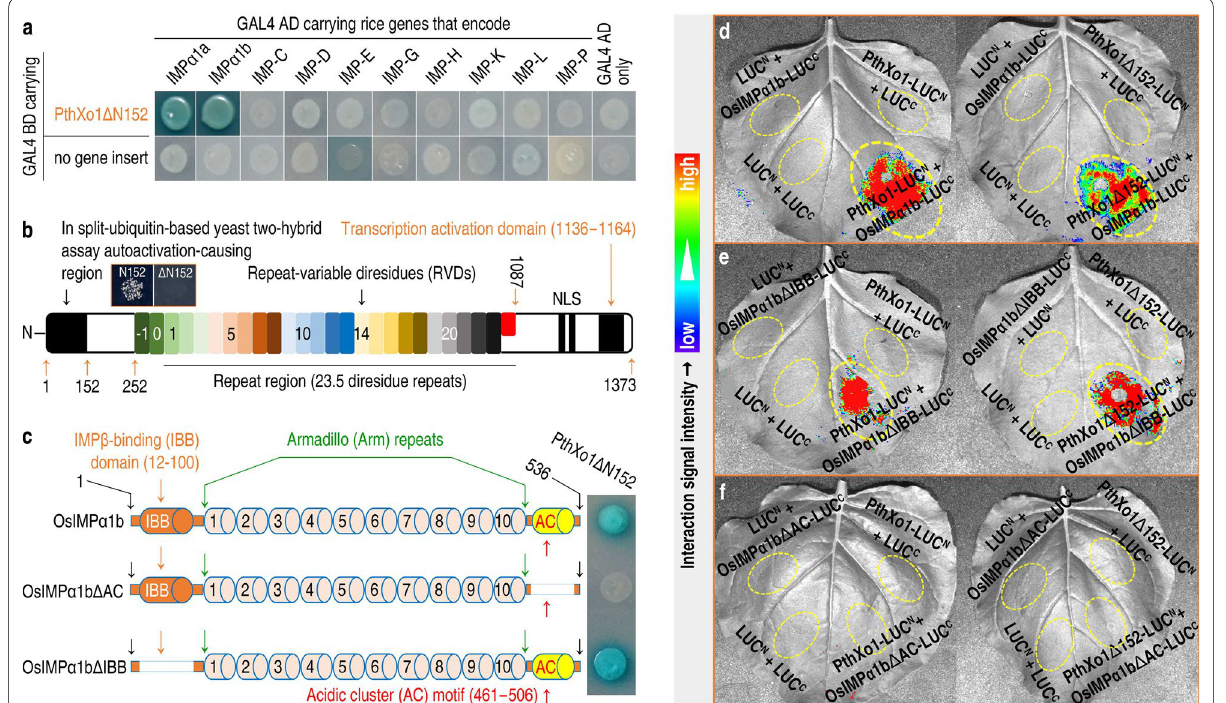
Fig. 1 OsIMPα1a and OsIMPα1b interact with PthXo1. a OsIMPα1a and OsIMPα1b were identified as interactors of PthXo1 in split-ubiquitin-based yeast two-hybrid (SUB-Y2H) assays of PthXo1 in combination with each of the indicated IMPs from rice. The protein ‒ protein interactions were detected by an X-Gal assay of colonies grown on synthetic dropout (SD)-amino acid tryptophan-leucine nutrient (SD-WL) media. b Diagram of PthXo1 structural components, including the 152-amino acid-long N-terminal sequence, which is responsible for autoactivation of the protein. The inset shows the presence and absence of colonies growing on SD-tryptophan-leucine-alanine-histidine (SD-WLAH) medium from yeast cultures that produce full-length PthXo1 protein or the PthXo1Δ152 variant lacking the first 152 amino acids. c An additional SUB-Y2H assay revealed acidic cluster (AC) motif, instead of IMPβ-binding (IBB) domain, as a recognition motif driving the interactions of OsIMPα1a and OsIMPα1b with PthXo1. In a and c , each colony represents 9 colonies investigated in 3 experimental replicates. d–f Luciferin (Luc) living fluorescence imaging (LLFI) assays performed on Nicotiana benthamiana leaves transformed with each pair of the indicated proteins. Luc N and Luc C represent the N-terminal and C-terminal halves of Luc fusion constructs of each tested proteins. Each leaf image represents 12 leaves of 6 plants tested in 3 experimental